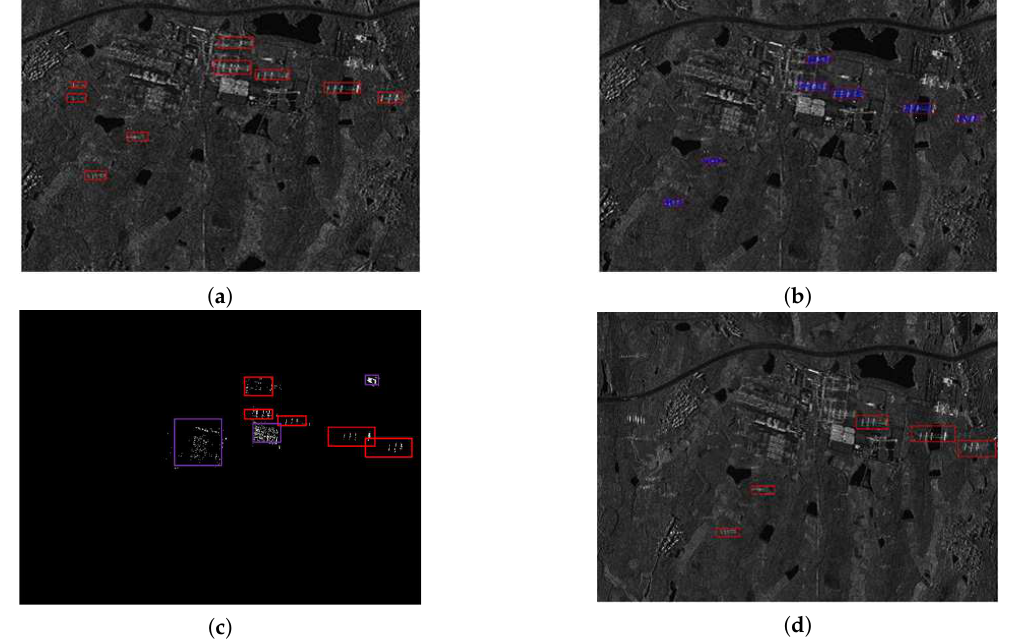
Figure 8. Target detection results using different algorithms. ( a ) original image; ( b ) MSDMC model; ( c ) global scattering center model; and ( d ) region-based model.